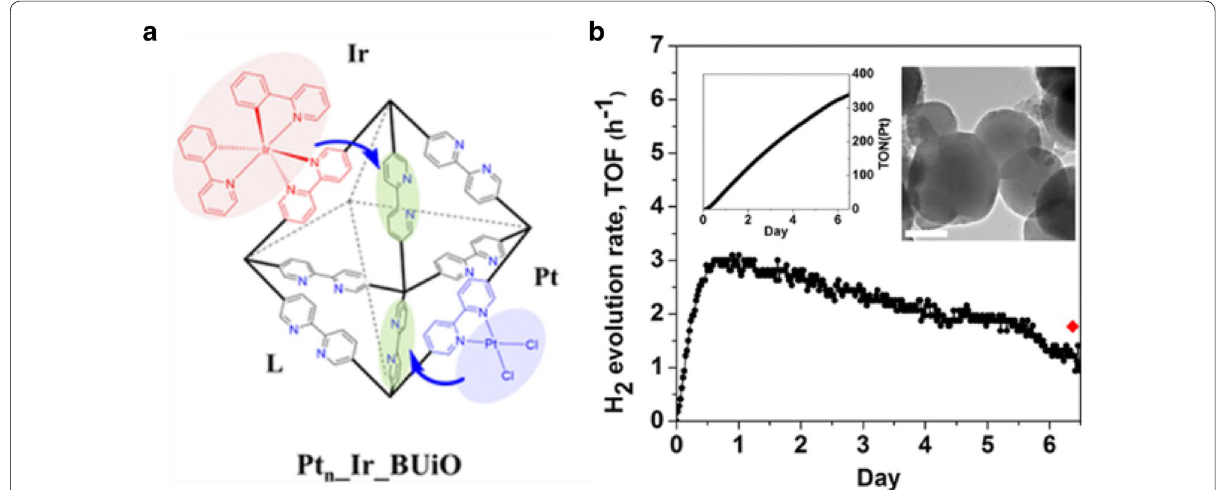
Fig. 5 a Schematic operation principle of self-healing MOF ( Pt n _Ir_BUiO ). b H 2 evolution rate curve of Pt 0.1 _Ir_BUiO . Inset: total amount of H2 evolved (left) and HR-TEM image after 6.5 days of photolysis. Scale bar